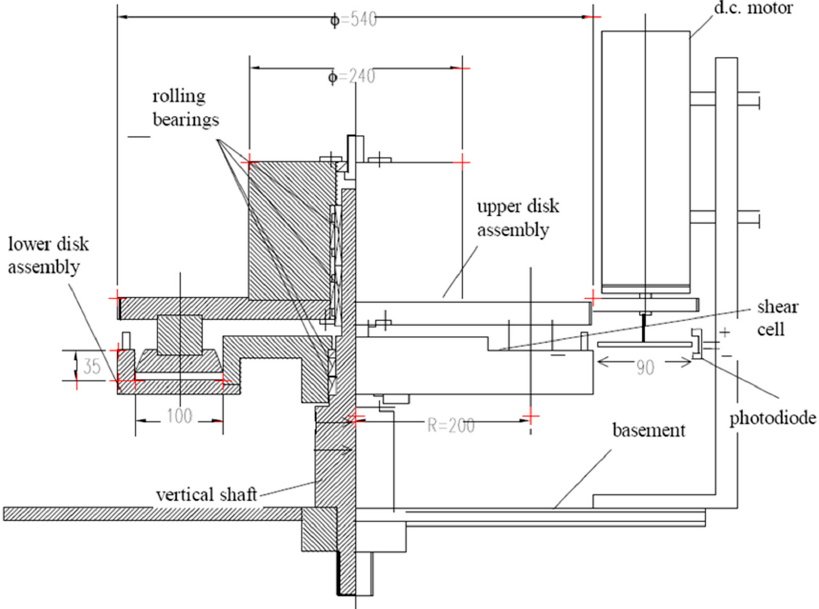
Figure 1. Experimental apparatus: section of the annular rheometer; measurements in mm (courtesy Schippa and Lamberti, [30]).